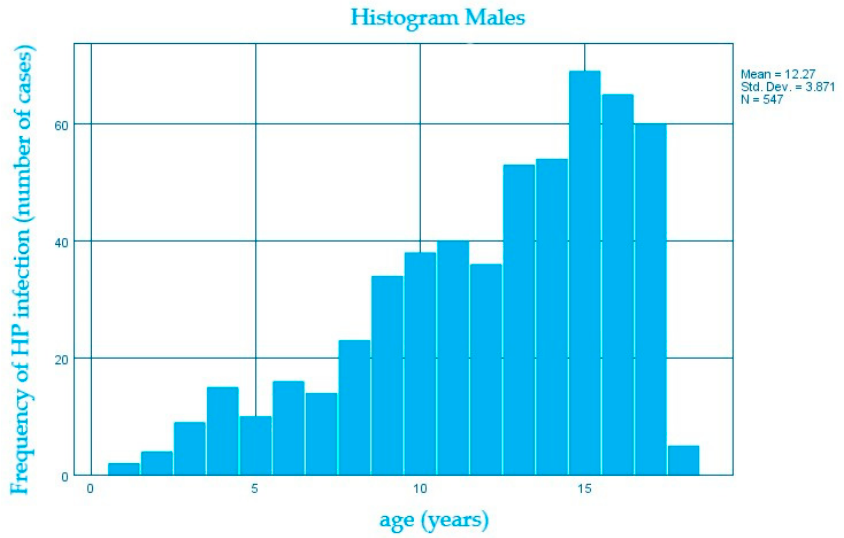
Figure 5. Distribution of H. pylori infection (number of cases) according to age (years) in males. A direct comparison between the median age of debut of the Helicobacter pylori infection for males and females demonstrates similarities between both genders (Figure 6).